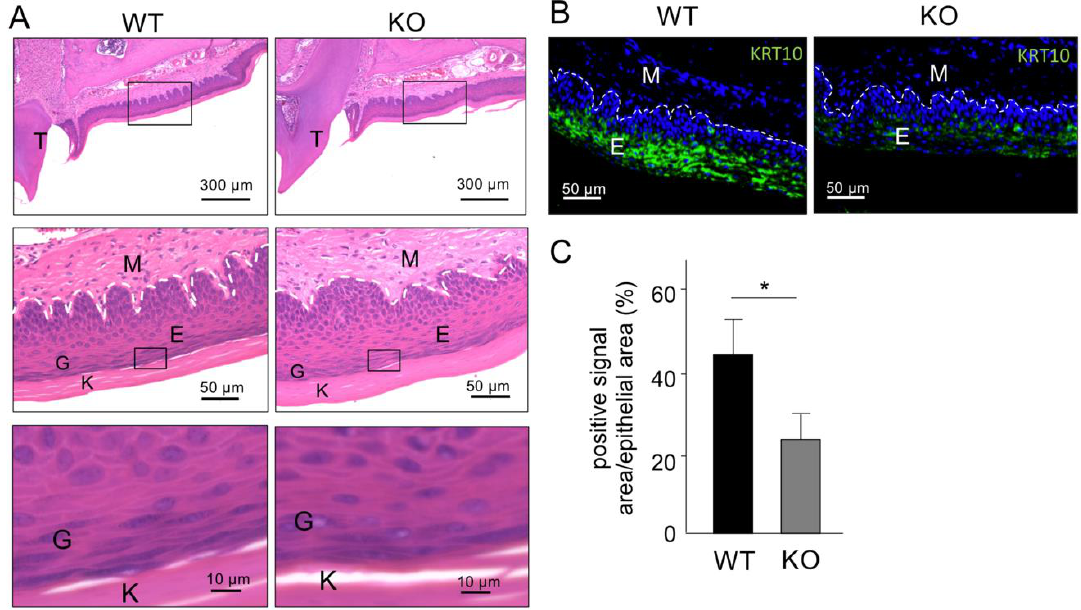
Figure 4. Histological comparison of keratinized mucosa between WT and Col18 -KO mice. ( A ) HE staining images of palatal mucosa of WT and Col18 -KO mice. Boxes indicate the area shown at higher magnification in the lower panels. Note that there is no difference between WT and Col18 -KO mice. ( B ) IHC staining images for KRT10 (green). ( C ) The percentage of positive signal for KRT10 in the area of palatal mucosa. Bars represent the mean values and standard deviation (+/−SD) ( n = 3). * p < 0.05 (Student’s t -tests). Note that the expression levels of KRT10 are lower in Col18 -KO mice compared to WT mice. T, tooth; G, granular layer; K, keratinized (cornified) layer. Results are representative of three independent experiments.